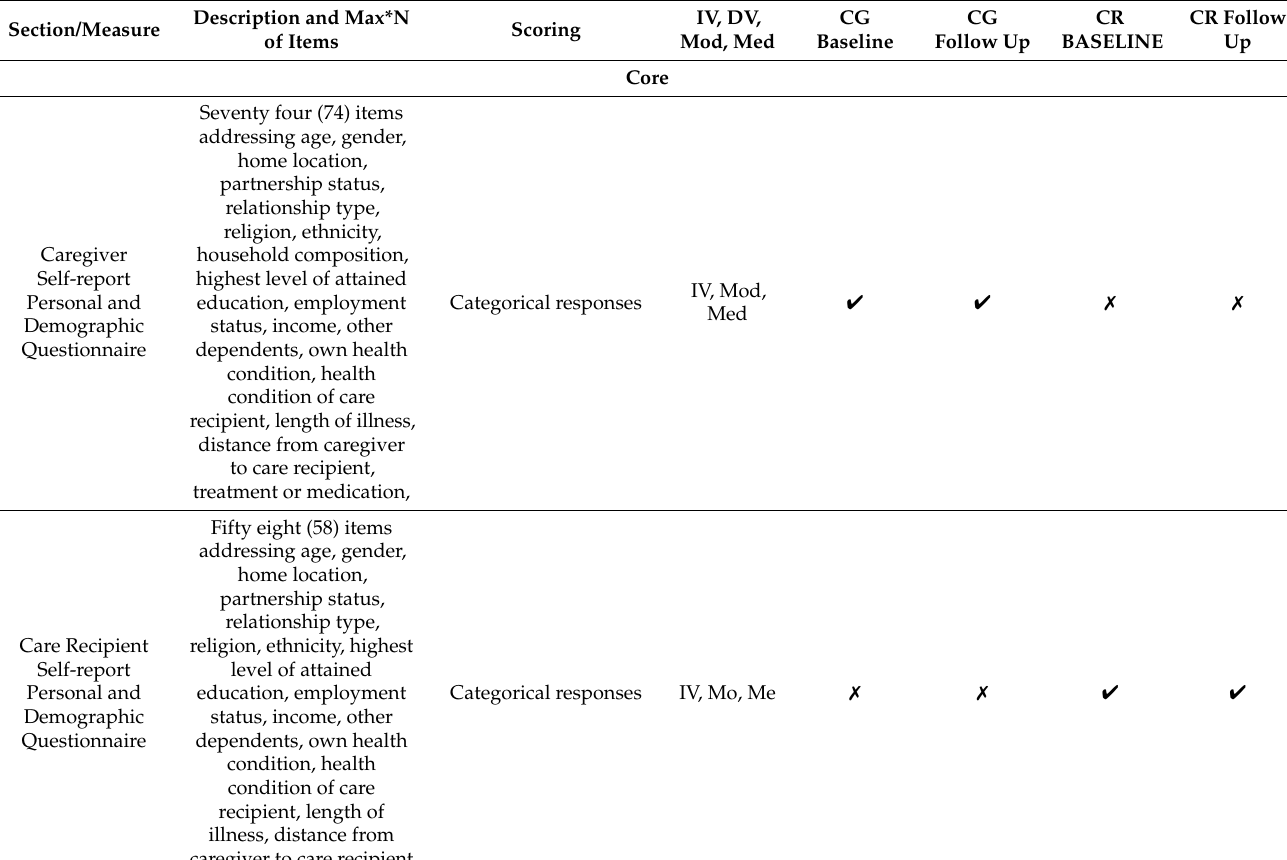
Table 1. Summary of